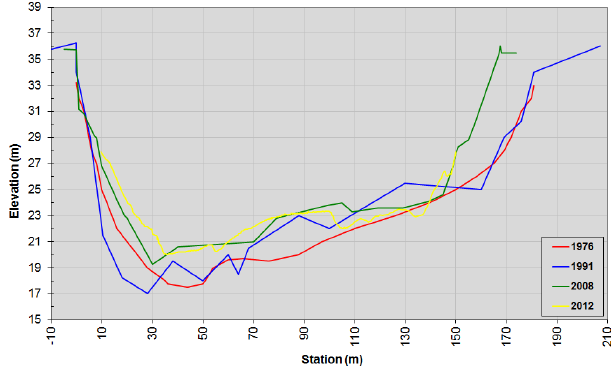
Figure 14. Cross section of River Tigris at Sari gauging station at different periods. Figure 14: Cross section of River Tigris at Sari gauging station at different